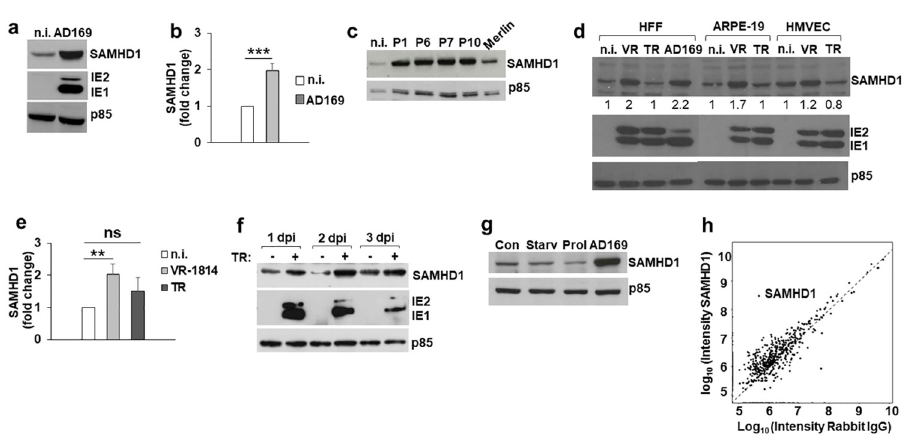
Fig 2. SAMHD1 protein expression in HCMV-infected cells. a) SAMHD1 levels were analyzed by immunoblotting in cell lysates of HFFs not infected (n.i.) or infected with AD169 at an MOI of 1 for 3 days. Expression of IE1/IE2 viral antigens was used as control for infection, while the p85 subunit of PI3K was used as loading control. A representative experiment out of six is shown. b) The relative amount of SAMHD1 protein, normalized to that of p85, was determined by densitometric analysis and is relative to that of n.i. cells, which was arbitrarily set as 1. Data are expressed as mean ± SE of eight independent experiments. c) SAMHD1 expression in HFFs not infected (n.i.) or infected with HCMV clinical isolates collected from infants affected by congenital HCMV infection (P1, P6, P7 and P10), or with Merlin. Data derive from one representative experiment out of two. d) SAMHD1 expression in HFFs, ARPE-19 and HMVEC cells infected with the indicated HCMV strains. Data derive from one representative experiment out of two, performed at the same time with all conditions. Numbers indicate the relative amount of SAMHD1 protein, determined as in panel b). e) The relative amount of SAMHD1 protein from HFFs infected with the indicated clinical strains was determined as in panel b). Data are expressed as mean ± SE of eight independent experiments. All data derive from cells infected at an MOI of 1 and harvested at 3 dpi. f) PMA-differentiated THP-1 cells not infected or infected with TR at an MOI of 1 for the indicated times. Expression of SAMHD1, viral antigens and p85 was evaluated as above. A representative experiment out of two is shown. g) SAMHD1 expression in HFFs induced to reach confluence (Con), serum-starved (Starv), proliferating (Prol), or infected with AD169 at an MOI of 1 for 3 days. Data derive from one representative experiment out of two. h) Antibody validation of the anti-SAMHD1 antibody by immunocapture MS. Proteins enriched by the antibody towards SAMHD1 ( y -axis) are plotted versus non- specific enrichment by one Rabbit IgG pool ( x- axis). Enriched proteins identified are quantified by label-free quantification and plotted as intensities (log 10 ). �� , p < 0.01; ��� , p < 0.001; ns, not significant.